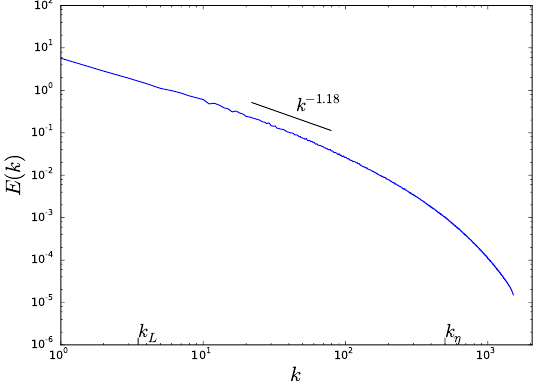
Figure 19. ( a ) typical realization of the velocity field u ( x , t ) in DNS of the intermediate case ( α = 0.15 in Equation (26)); ( b ) velocity field realization that belongs to the largest velocity field gradient that was attained in the DNS.